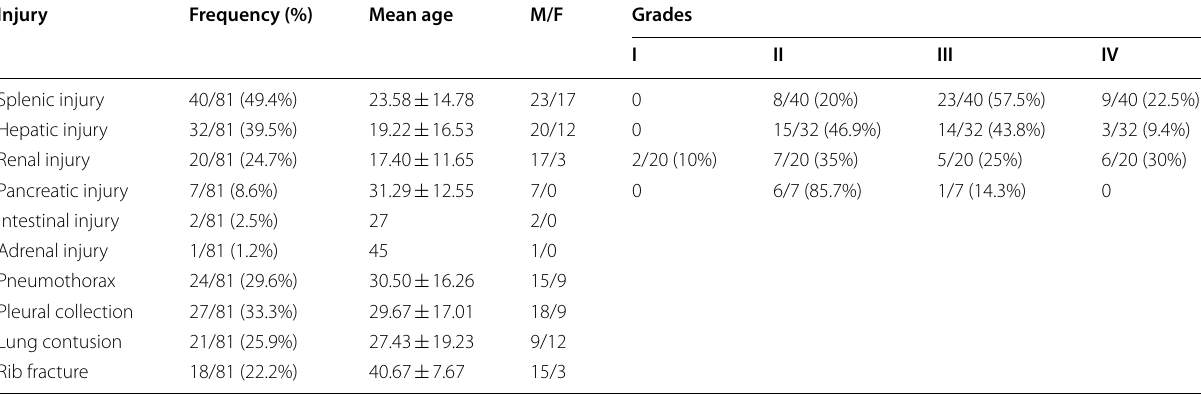
Data were expressed in form of frequency (percentage), mean (age). M/F: male/female